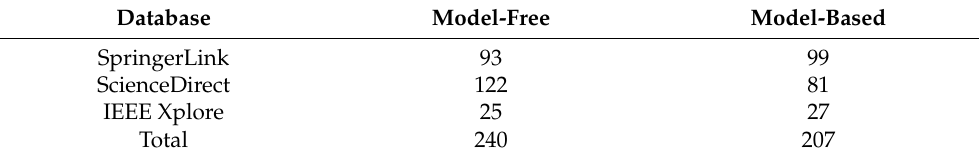
Table 1. Number of articles for model-based and model-free reinforcement learning